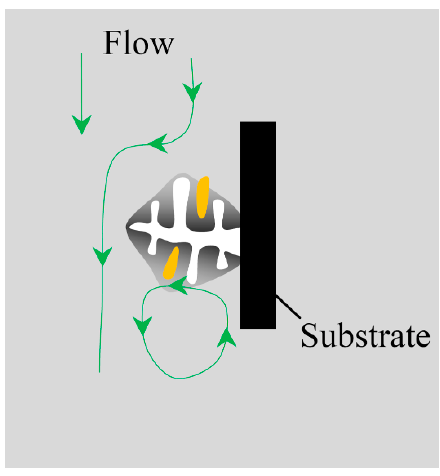
Figure 9. Schematic view of the high ‐ order dendrite arms detachment under the forced flow (yellow: detached dendrite arms). Metals 2016 , 6 , 170